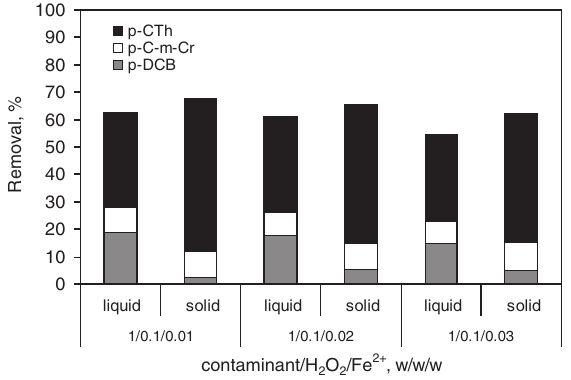
Fig. 3. p-DCB, p-C-m-Cr, p-CTh removal (% of initial content) in the soil after 24 h of treatment with liquid hydrogen peroxide and percarbonate with the addition of supplemental ferrous